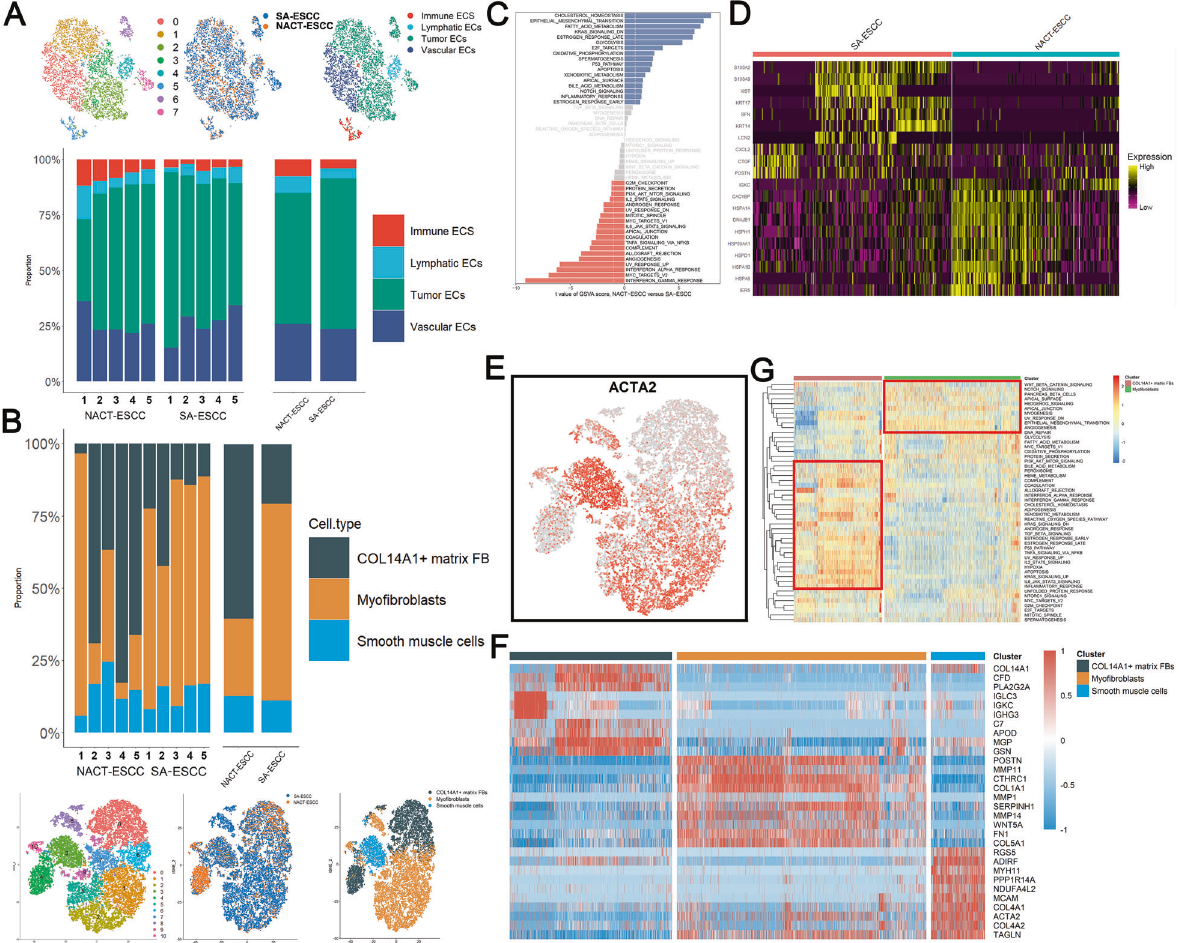
Fig. 4 The scRNA Pro fi les for Stromal Cell Lineages in SA-ESCC and NACT-ESCC. A The TSNE plot and the proportion of endothelial cells in SA-ESC and NACT-ESCC samples. B The TSNE plot and proportion of fi broblasts in SA-ESC and NACT-ESCC samples. C Differences in pathway activities scored per cell by GSVA among immune EDCs under SA-ESCC and NACT-ESCC conditions. Normalized pathways scores. D Heatmap showing the activity of marker genes of immune EDCs in SA-ESCC and NACT-ESCC conditions. E Feature plot of ACTA2 in fi broblasts. F Heatmap showing the activity of marker genes in each fi broblasts subtypes. (G) Differences in pathway activities scored per cell by GSVA among COL14A1 + matrix fi broblasts and myo fi broblasts. Normalized pathways COL14A1 + matrix fi broblasts have been reported in the non- SA-ESCC group (Fig. 4A). Therefore, tumor and immune EDCs were malignant stromal environment [20, 21]. We found that COL14A1 + used for downstream analyses. GSVA analysis revealed that matrix fi broblasts were mainly enriched in NACT-ESCC, compared metabolic pathways, including cholesterol homeostasis and fatty to SA-ESCC, whereas myo fi broblasts were mainly enriched in the acid metabolism, were activated in tumor EDCs in NACT-ESCC SA-ESCC group (Fig. 4B). Alpha smooth muscle actin ( α -SMA) (Fig. 4C). In contrast, tumor EDCs from ESCC were found to be (ACTA2 gene product), was used as the marker protein for enriched in pathways that regulate endothelial cell development myo fi broblasts to con fi rm their in fi ltration. ACTA2 was found to be and cell fate (e.g., MYC related pathways and angiogenesis) mainly expressed in myo fi broblasts and smooth muscle cells, [14, 15]. Analysis of differentially expressed genes between which explains their contractile ability (Fig. 4E). In addition, POSTN immune EDCs from SA-ESCC and NACT-ESCC revealed that and WNT5A, which are closely correlated with Wnt and Notch cancer-promoting genes (e.g., S100A family genes) were highly signaling pathways [22], were found to be highly expressed in expressed in SA-ESCC [16, 17] (Fig. 4D), while expressions of HSP myo fi broblasts (Fig. 4F). Moreover, GSVA analysis revealed that the family genes were signi fi cantly elevated in the NACT-ESCC group. Wnt and Notch signaling pathways were enriched in myo fi bro- Overexpressed HSP family genes have been reported to promote blasts. COL14A1 + matrix fi broblasts play a vital role in defenses cancer growth and metastasis in several tumors, implying that HSP against abnormal stress levels in the stromal microenvironment family genes are potential therapeutic targets for NACT-ESCC (Fig. 4G). [18, 19]. In addition, functional enrichment analyses revealed that marker genes for SA-ESCC derived immune EDCs were implicated Macrophages play different roles in NACT-ESCC and SA-ESCC in biological regulation and cell growth, whereas marker genes for Based on the expressions of CD68 and LYZ, a total of 16,305 immune EDCs in the NACT-ESCC group were mainly involved in cellular and immune responses (Supplementary Fig. 4C). myeloid cells were selected and re-clustered, resulting in ten Myo fi broblasts play a key role in tumor progression, and have clusters, mainly comprising monocytes, macrophages, dendritic been described as cancer-associated fi broblasts, whereas cells, and unde fi ned myeloid cells (Fig. 5A and Supplementary